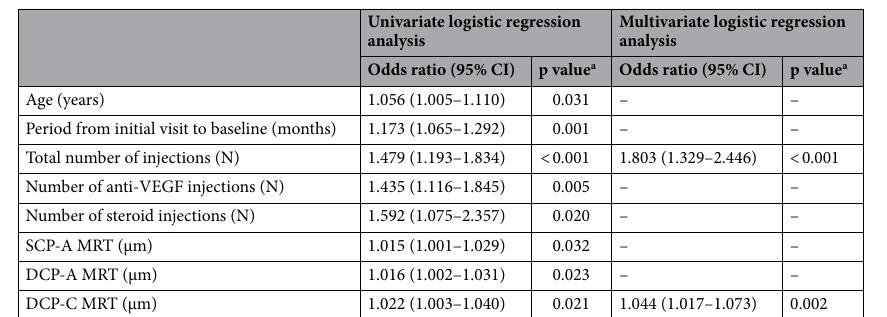
Table 4. Logistic regression analysis of the recurrence of macular edema. CI confidence interval, VEGF vascular endothelial growth factor, SCP-A superficial capillary plexus-abnormal vessel area, MRT mean retinal thickness, DCP-A deep capillary plexus-abnormal vessel area, DCP-C deep capillary plexus-congestion area. a All values are the results of logistic regression analysis.